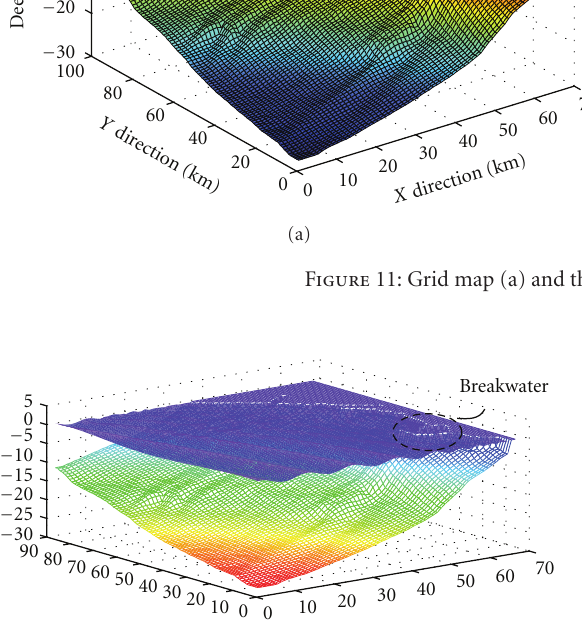
Figure 12: Wave height distribution in the coastal zone.